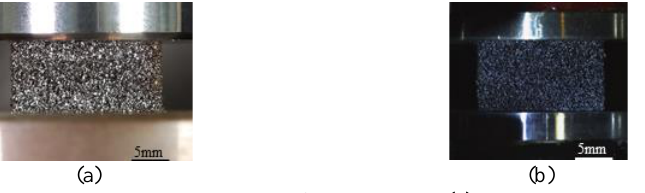
Fig. 2. The random pattern applied on the side of the test piece; (a) in the quasi-static test, (b) in the dynamic test.